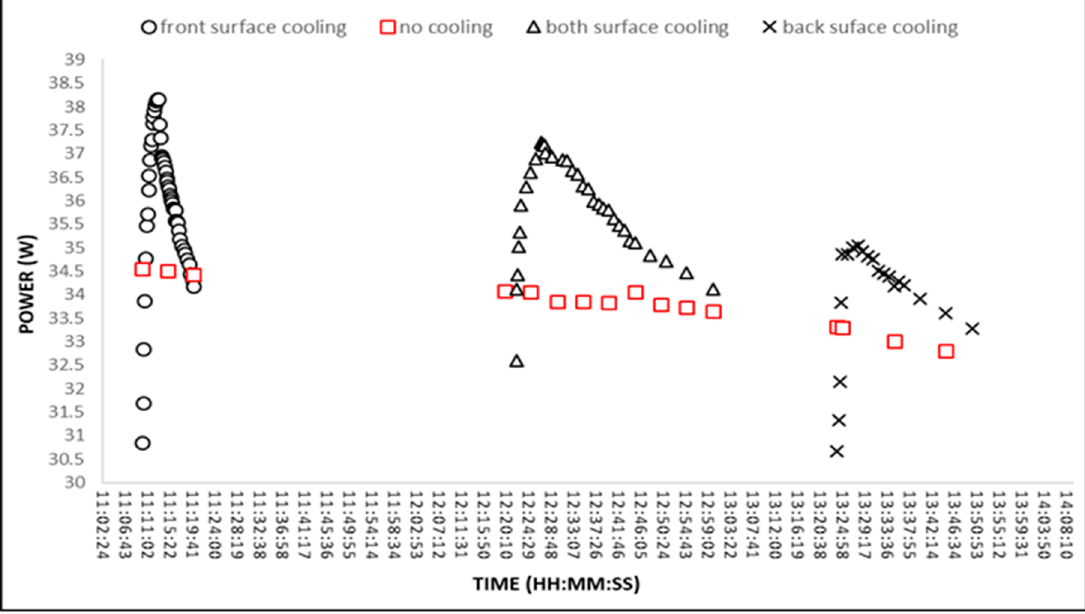
Figure 3. The output power of PV vs. time for front and back surface cooling.